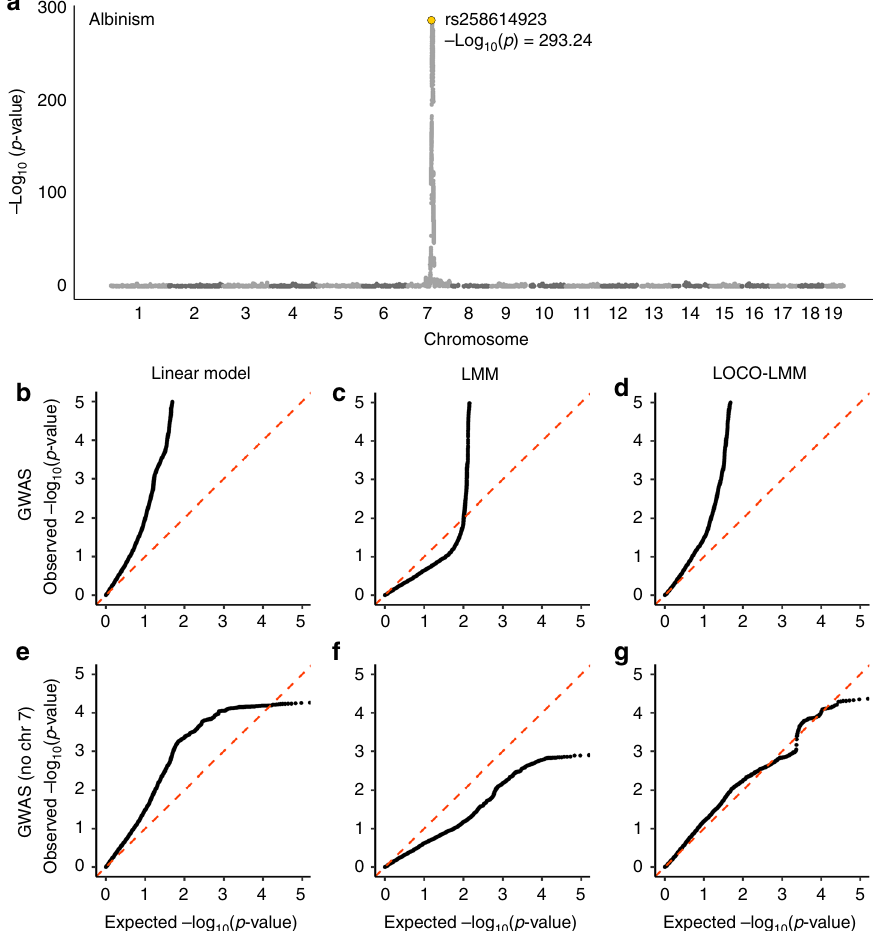
Fig. 2 GWAS for albinism veri fi es that the LOCO-LMM effectively controls type I and type II error. We conducted a GWAS for albinism, a Mendelian trait caused by the Tyr c locus on mouse chromosome 7, using three models: a linear model, an LMM, and a LOCO-LMM. We also repeated each scan after excluding SNPs on chromosome 7. A Manhattan plot of results from the LOCO-LMM is shown in ( a ). Quantile-quantile plots of expected vs. observed p -values are shown for ( b ) a simple linear model that does not account for relatedness; c a standard LMM that includes all GWAS SNPs in the GRM (i.e., the random effect); and d a LOCO-LMM whose GRM excludes SNPs located on the chromosome being tested. Plots e – g show results after excluding chromosome 7 from the